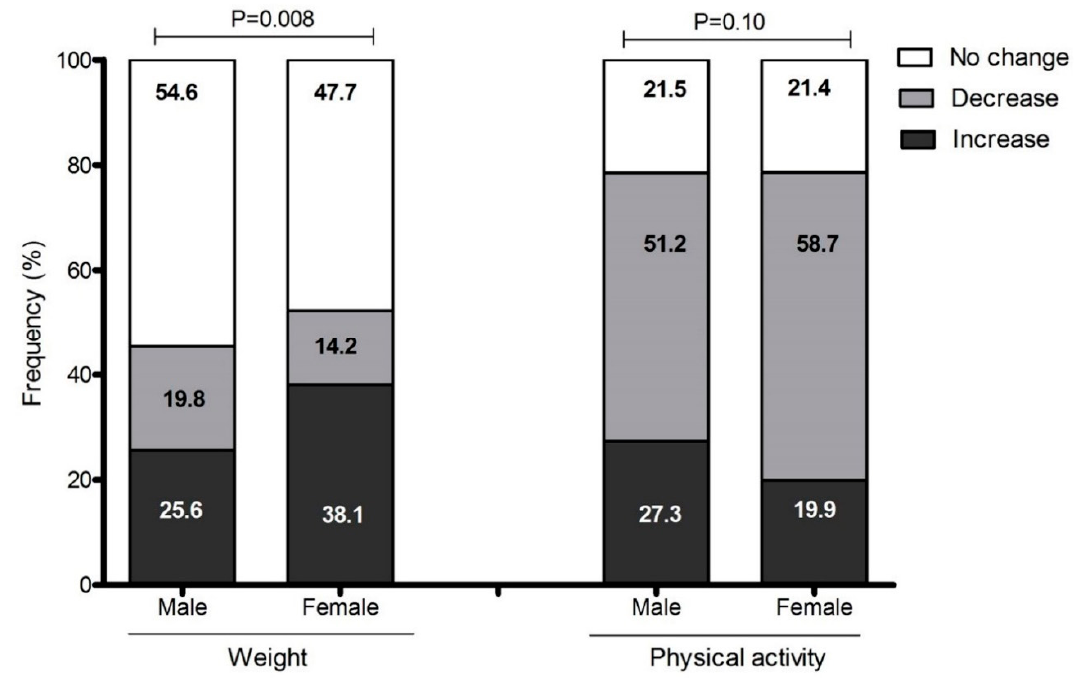
Figure 1. Perception of change in body weight and physical activity patterns during COVID-19 confinement.